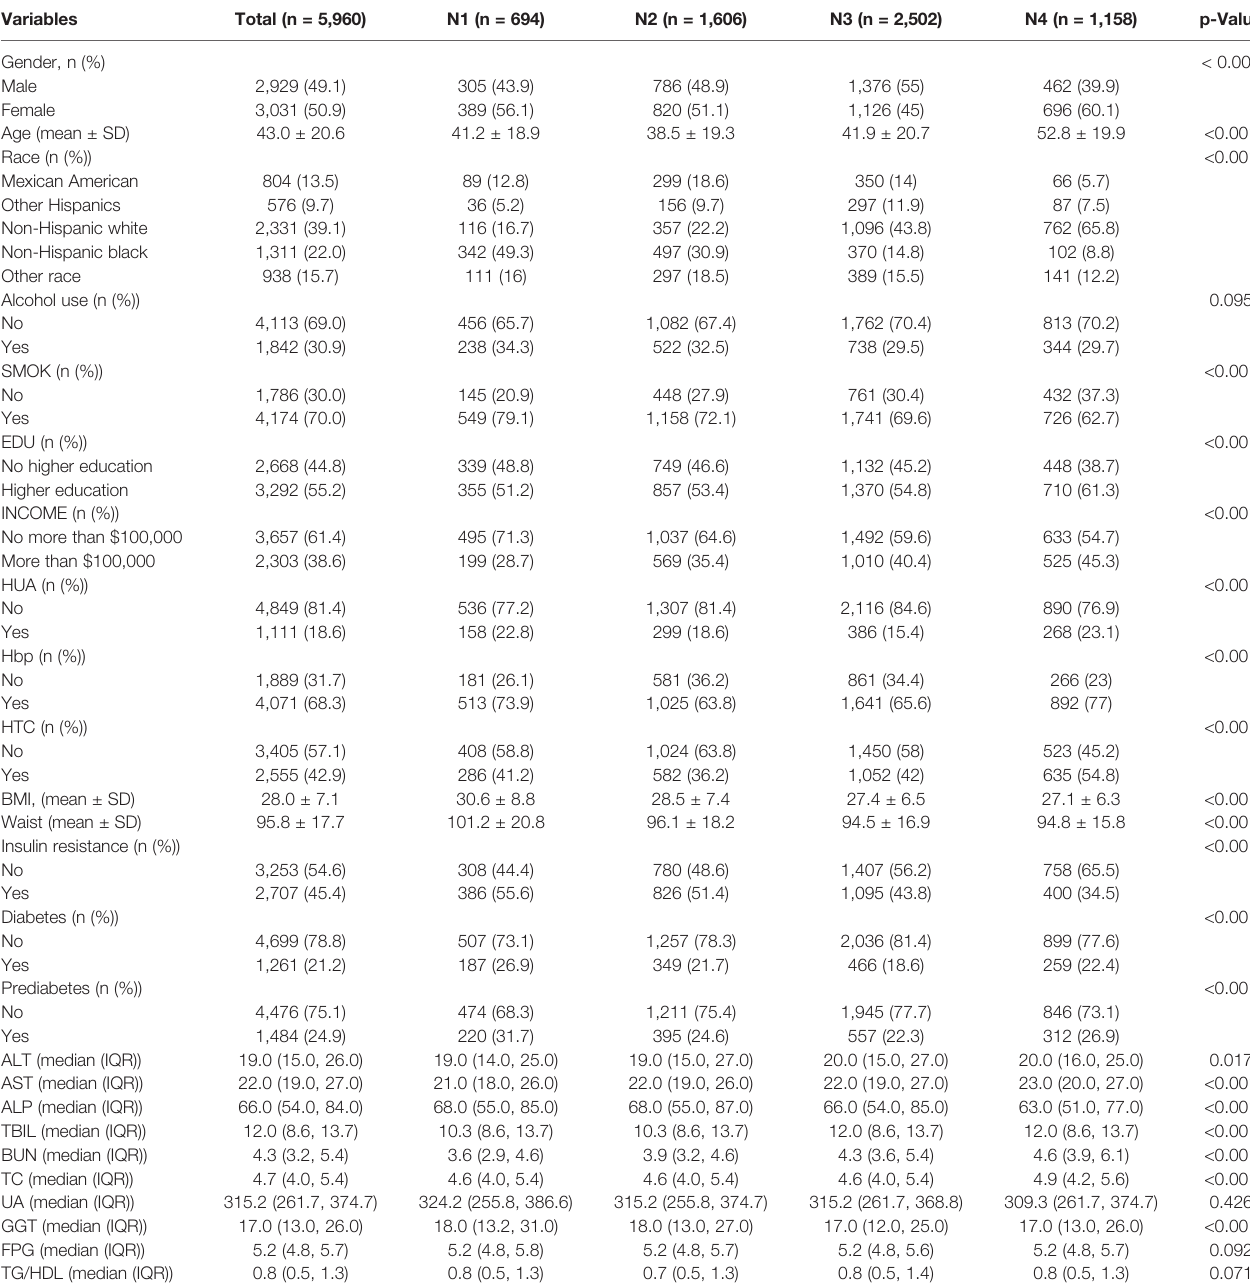
TABLE 1 | Basic characteristics of the participants. Variables p-Value Gender, n